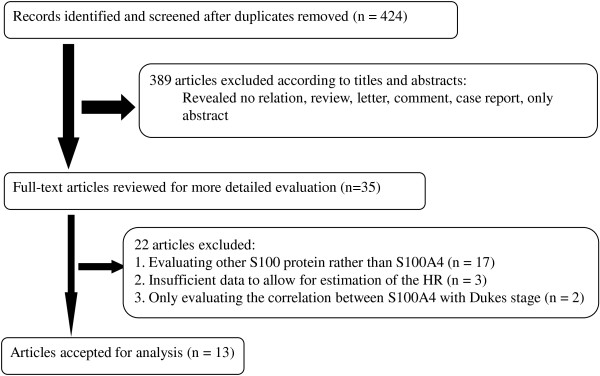
Flow chart depicting the selection of eligible studies.